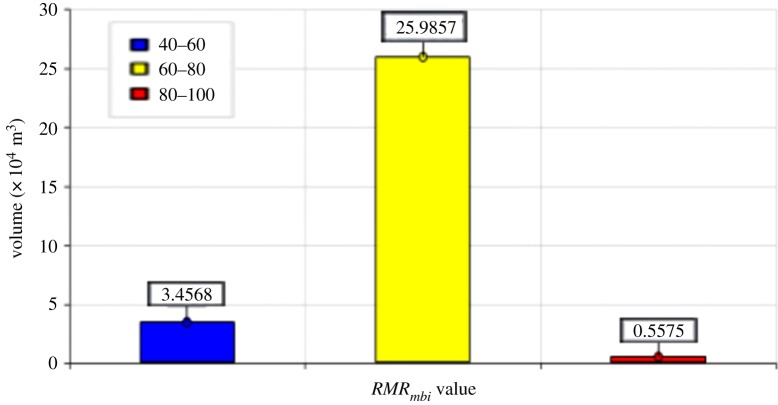
Histogram of volumes of rock masses in different RMRmbi classes.